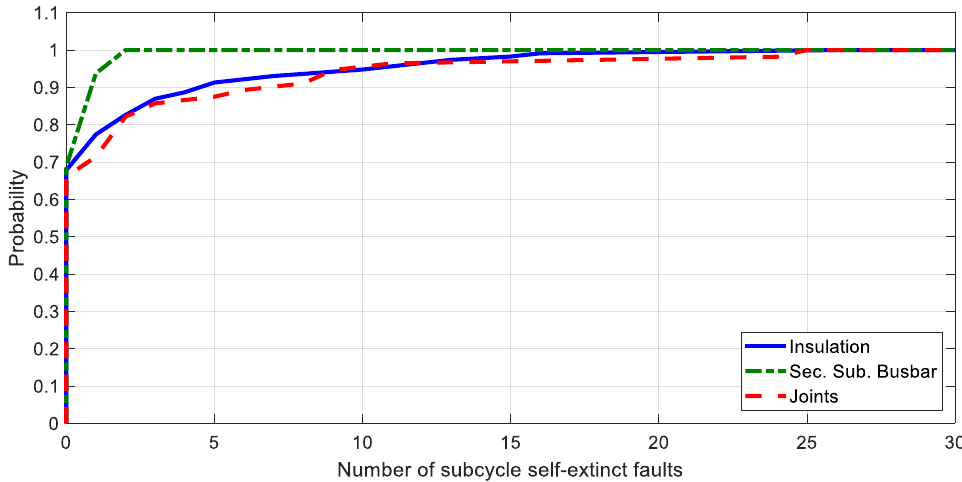
Figure 4. Observed cumulative probability for the number of sub-cycle self-extinct faults.